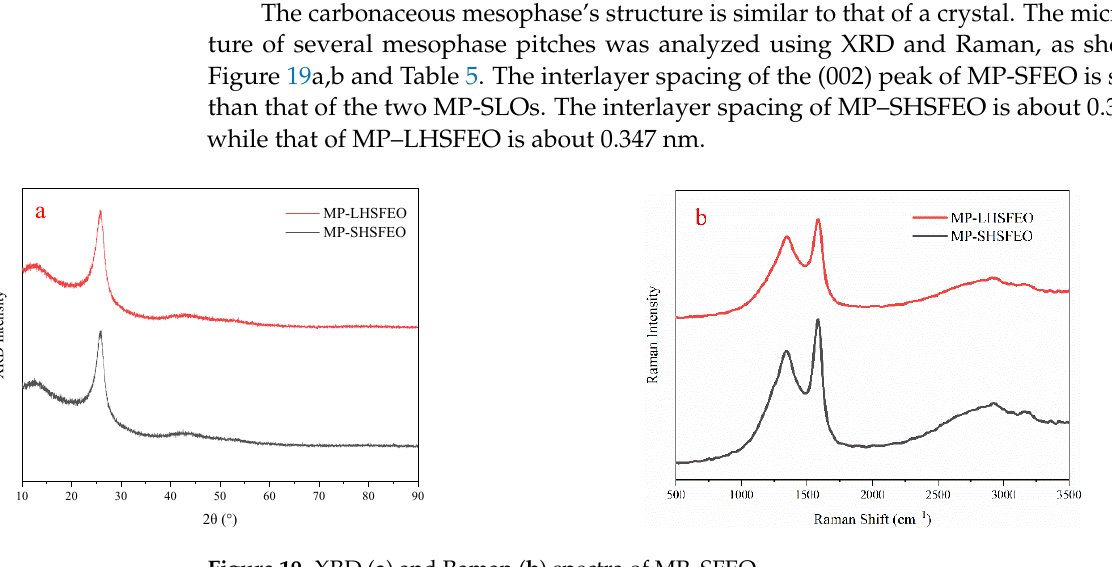
Figure 19. XRD ( a ) and Raman ( b ) spectra of MP–SFEO. Table 5. Structural performance parameters of several mesophase pitch.